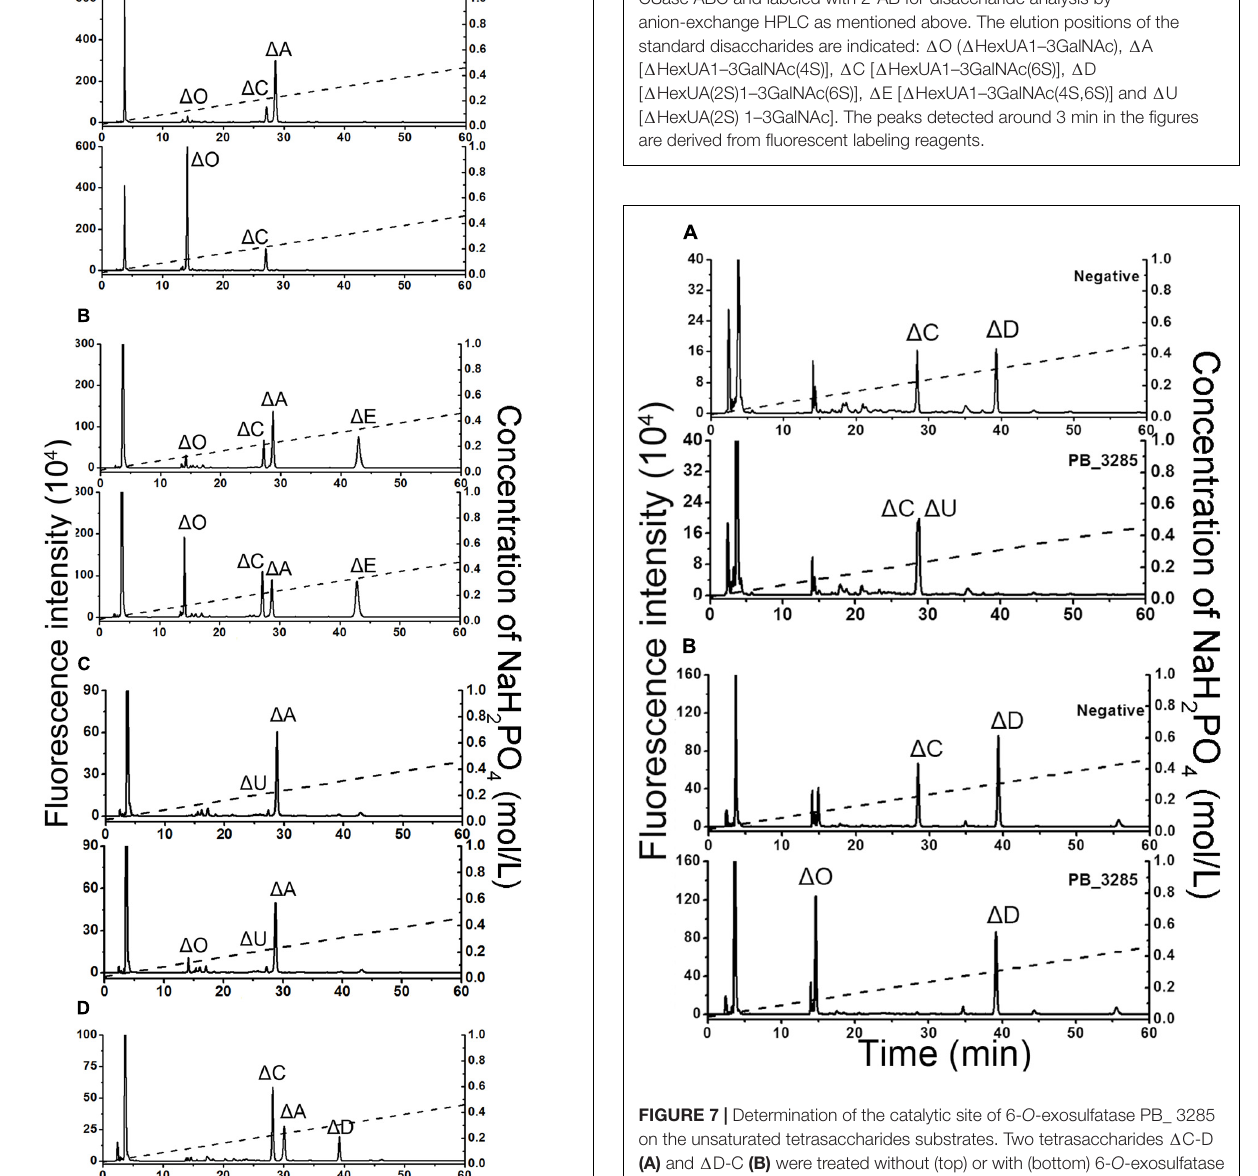
FIGURE 7 | Determination of the catalytic site of 6- O -exosulfatase PB_ 3285 on the unsaturated tetrasaccharides substrates. Two tetrasaccharides (cid:49) C-D (A) and (cid:49) D-C (B) were treated without (top) or with (bottom) 6- O -exosulfatase PB_3285. After degradation with CSase ABC, the disaccharide composition of each tetrasaccharide was analyzed by anion-exchange HPLC as described in section “Materials and Methods.” The elution positions of the standard disaccharides are indicated: (cid:49) O ( (cid:49) HexUA1–3GalNAc), (cid:49) C [ (cid:49) HexUA1–3GalNAc(6S)], (cid:49) D [ (cid:49) HexUA(2S)1–3GalNAc(6S)] and (cid:49) U [ (cid:49) HexUA(2S)1–3GalNAc]. The peaks detected around 3 min in the figures are derived from fluorescent labeling reagents.